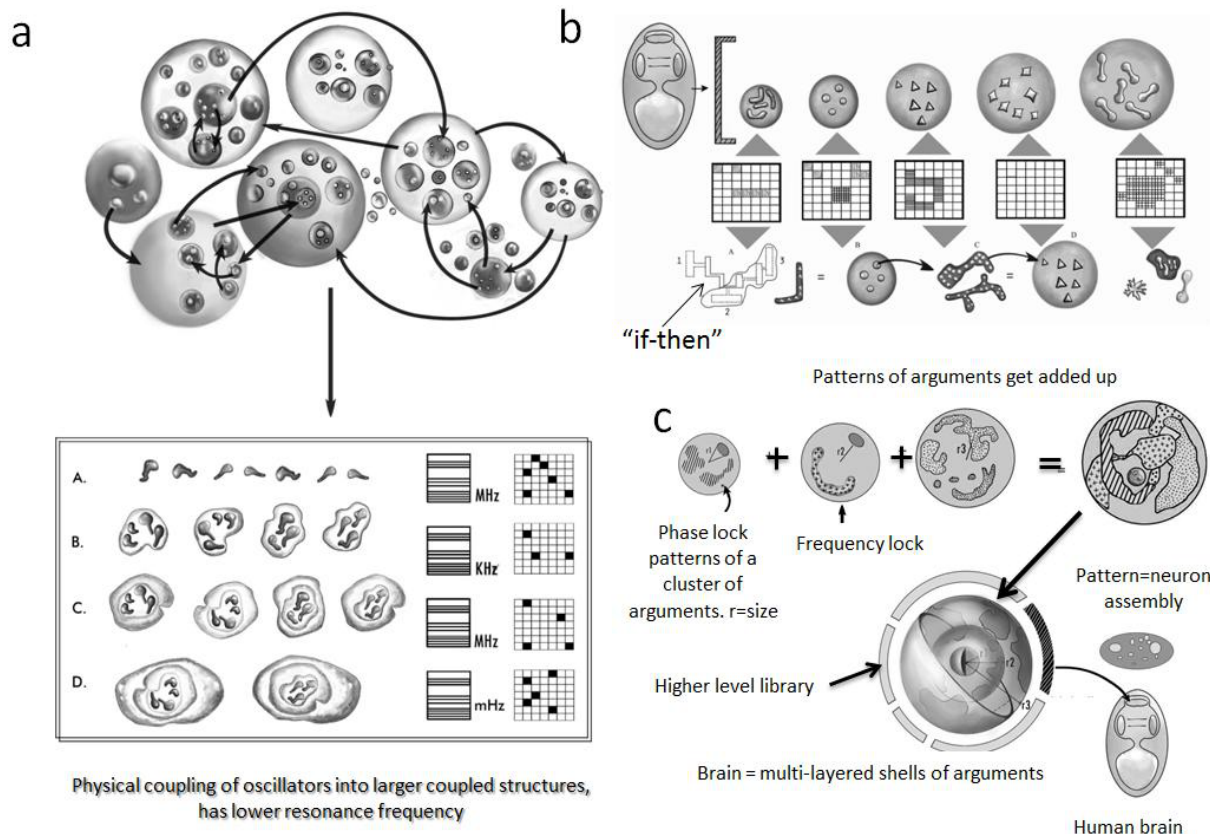
Figure 7. ( a ) More is the ―if-then‖ arguments, bigger is the sphere. Arrows denote coupling (top). Seed A makes B and so on (bottom). Resonance band and 2D graph of arguments are same; ( b ) Self-assembly of arguments form a cluster, these clusters self-assemble again; ( c ) Spheres of different radius denotes nature of ―fractal seed‖ assembly. All patterns plot together do not overlap. This is the principle of superposition of